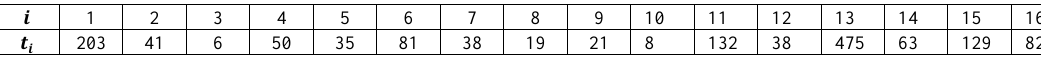
Table 3. Time between failure of an AMC ambassador data.